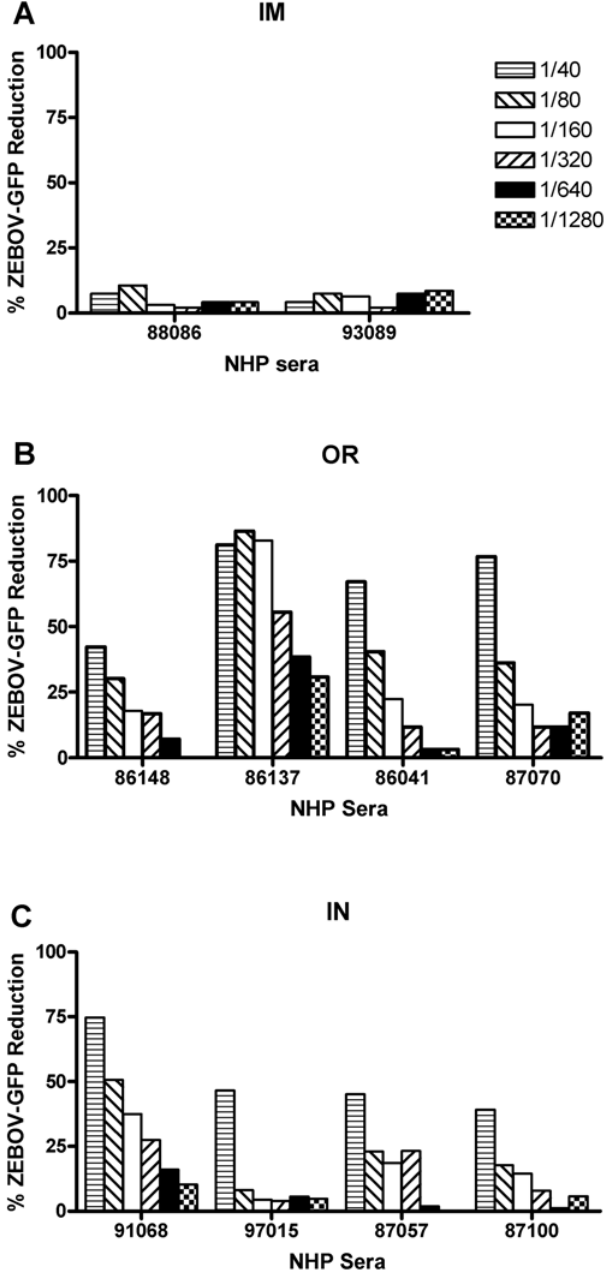
Figure 3. Neutralizing antibodies generated by the various immunization routes. ZEBOV GP-specific neutralizing antibodies in the sera from NHPs vaccinated either (A) intramuscularly (IM), (B) orally (OR), or (C) intranasally (IN), were investigated for their ability to inhibit infection by ZEBOV-GFP. NHP sera from days 0 and 21 post-vaccination were incubated for 1 hour with ZEBOV-GFP before being added to a monolayer of Vero cells. The positive control was ZEBOV-GFP in DMEM without sera. The level of GFP fluorescence of ZEBOV-GFP infected cells was determined by flow cytometry. The percent reduction of infection by ZEBOV-GFP was calculated as follows: % ZEBOV-GFP reduc- tion=(1 2 (Test samples/Positive control)) 6 100). The day 21 results for each NHP are displayed and have been normalized by subtracting each NHP’s day 0 results from the day 21 results. The numbers in the legend represent the dilution of the NHP sera that was added to ZEBOV-GFP.